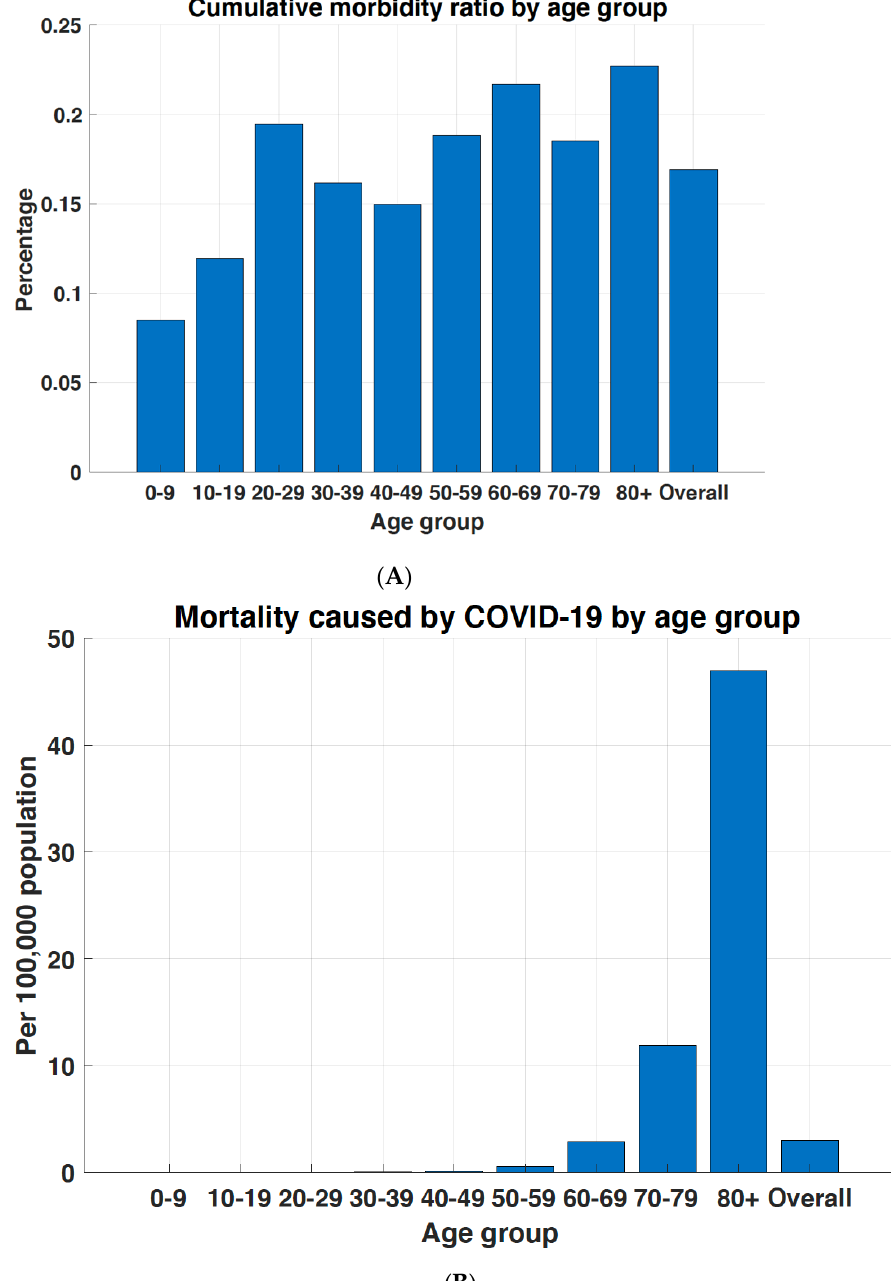
Figure 2. Mortality rate due to COVID-19 according to age group in South Korea as of 23 February 2021. ( A ) Cumulative COVID-19 incidence rate according to age group; ( B ) COVID-19 mortality rate according to age group.